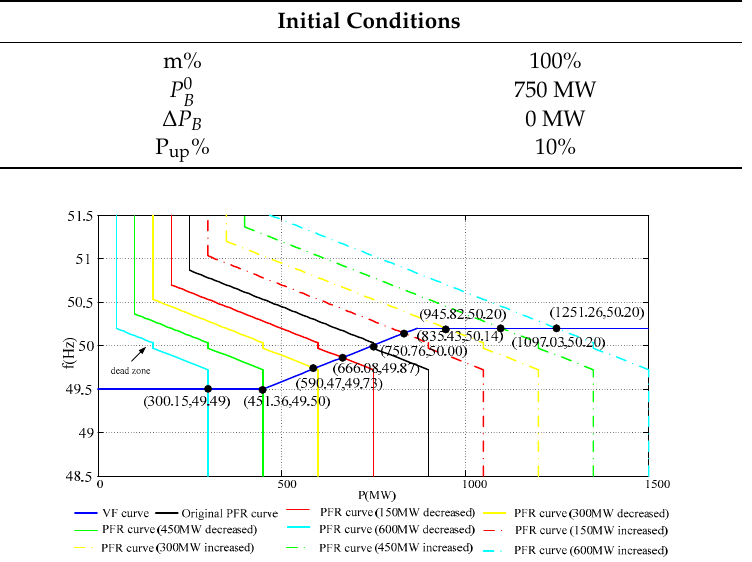
Table 2. The initial conditions.